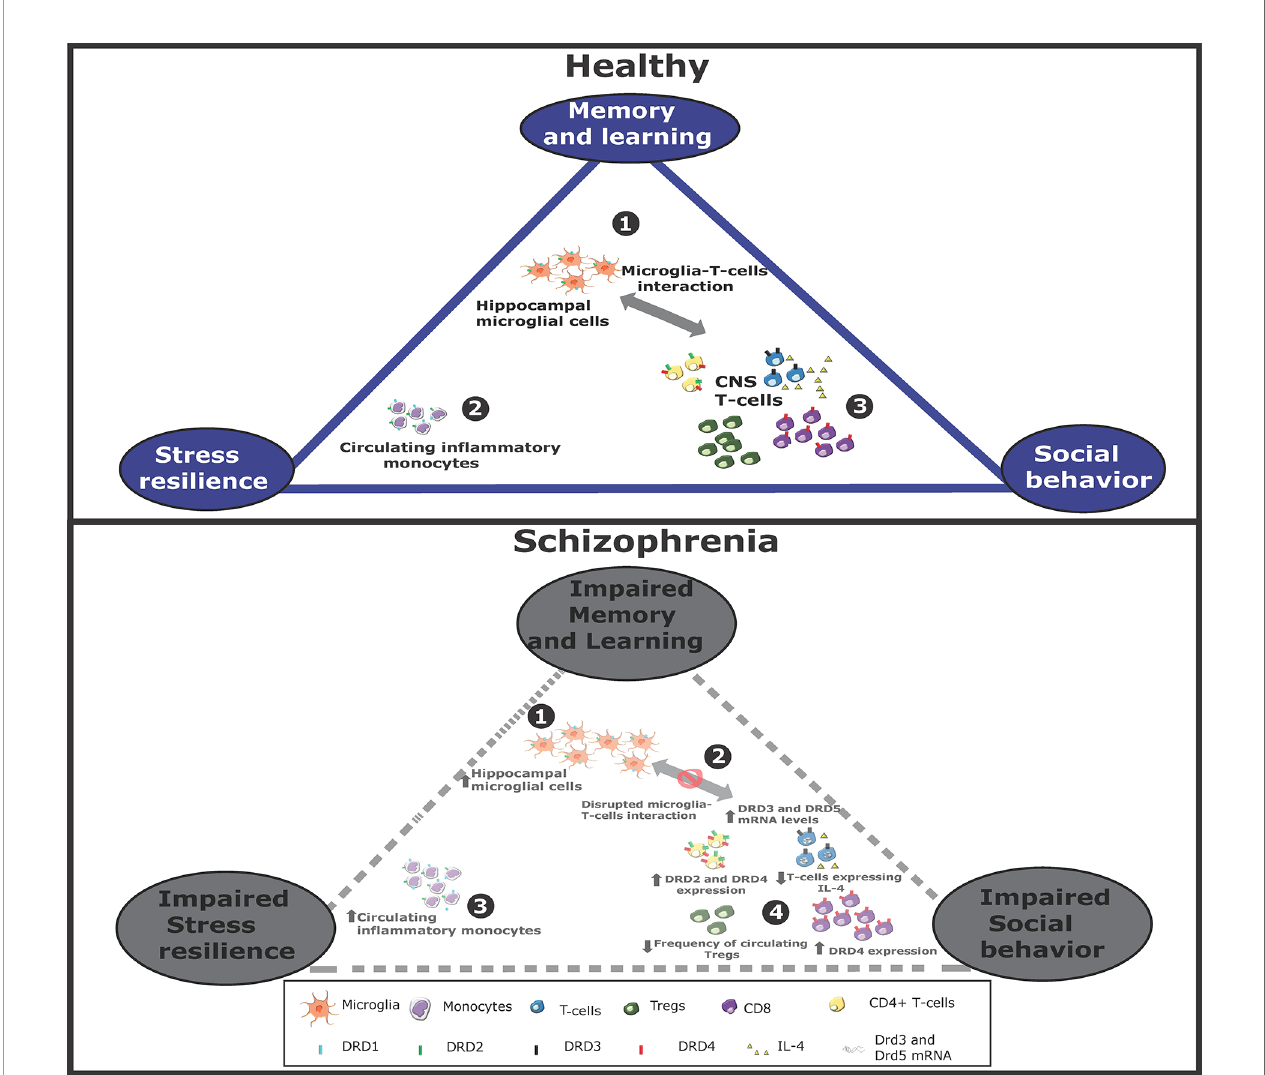
FIGURE 1 | Altered dopaminergic signaling in monocytes, T-cells, and microglia associated to schizophrenia. Schematic representation of immune cells associated to cognitive/behavioral function in healthy conditions (top panel) or in schizophrenia (bottom panel). Top panel: In healthy conditions, 1. microglial cells stimulate to T- cells in fi ltrated into the CNS. 2. Peripheral monocytes might also in fi ltrate the brain and favor T-cell activation. 3. Activated T-cells contribute to stress resilience. Some T-cells acquire Th2 phenotype and produce IL-4, which favors neurogenesis and thereby memory and learning. Some T-cells acquire Th1 features, produce IFN- g and promote social behavior. Bottom panel: In schizophrenia, 1. the interaction between microglia and T-cells is impaired, 2. thereby attenuating T-cell activation. Moreover, the expression of different dopamine receptors is altered, changing the extent of T-cell activation and differentiation. 3. Furthermore, the extent of peripheral monocytes and hippocampal microglia are increased, 4. whereas Treg frequency is reduced. All these changes hypothetically contribute to a reduced social behavior, decreased stress resilience and in impaired memory and